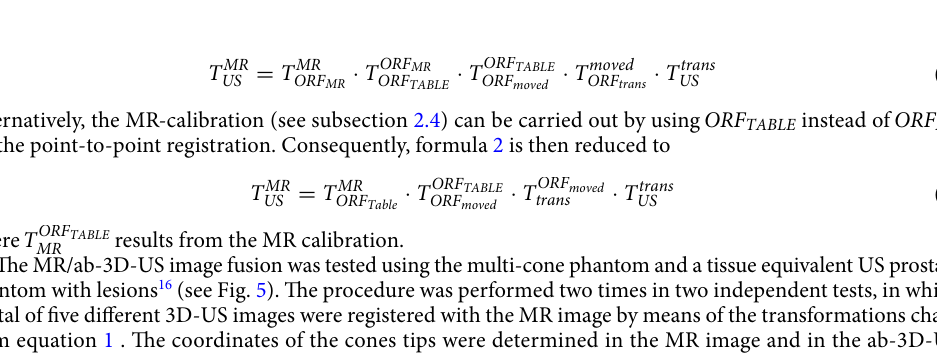
Figure 5. Tissue equivalent US prostate phantom with